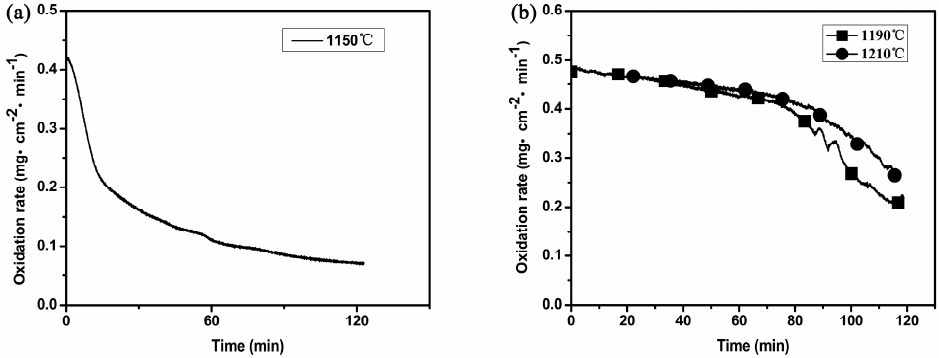
Figure 5. Oxidation rate versus time during the isothermal holding period: ( a ) 1150 °C; ( b ) 1190 °C and 1210 °C.